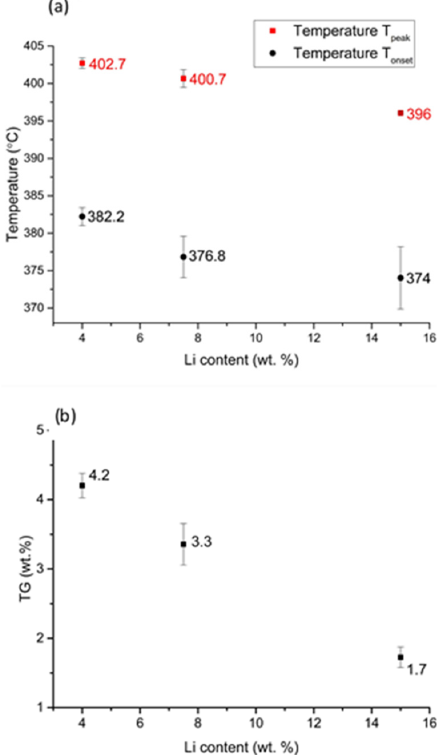
Figure 5. DSC ( a ), TGA ( b ) and MS ( c ) curves for alloys with various Li contents.